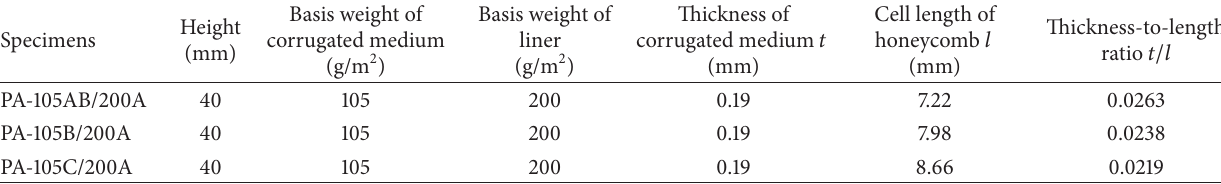
Table 1: Characteristics of honeycomb paperboard specimens.